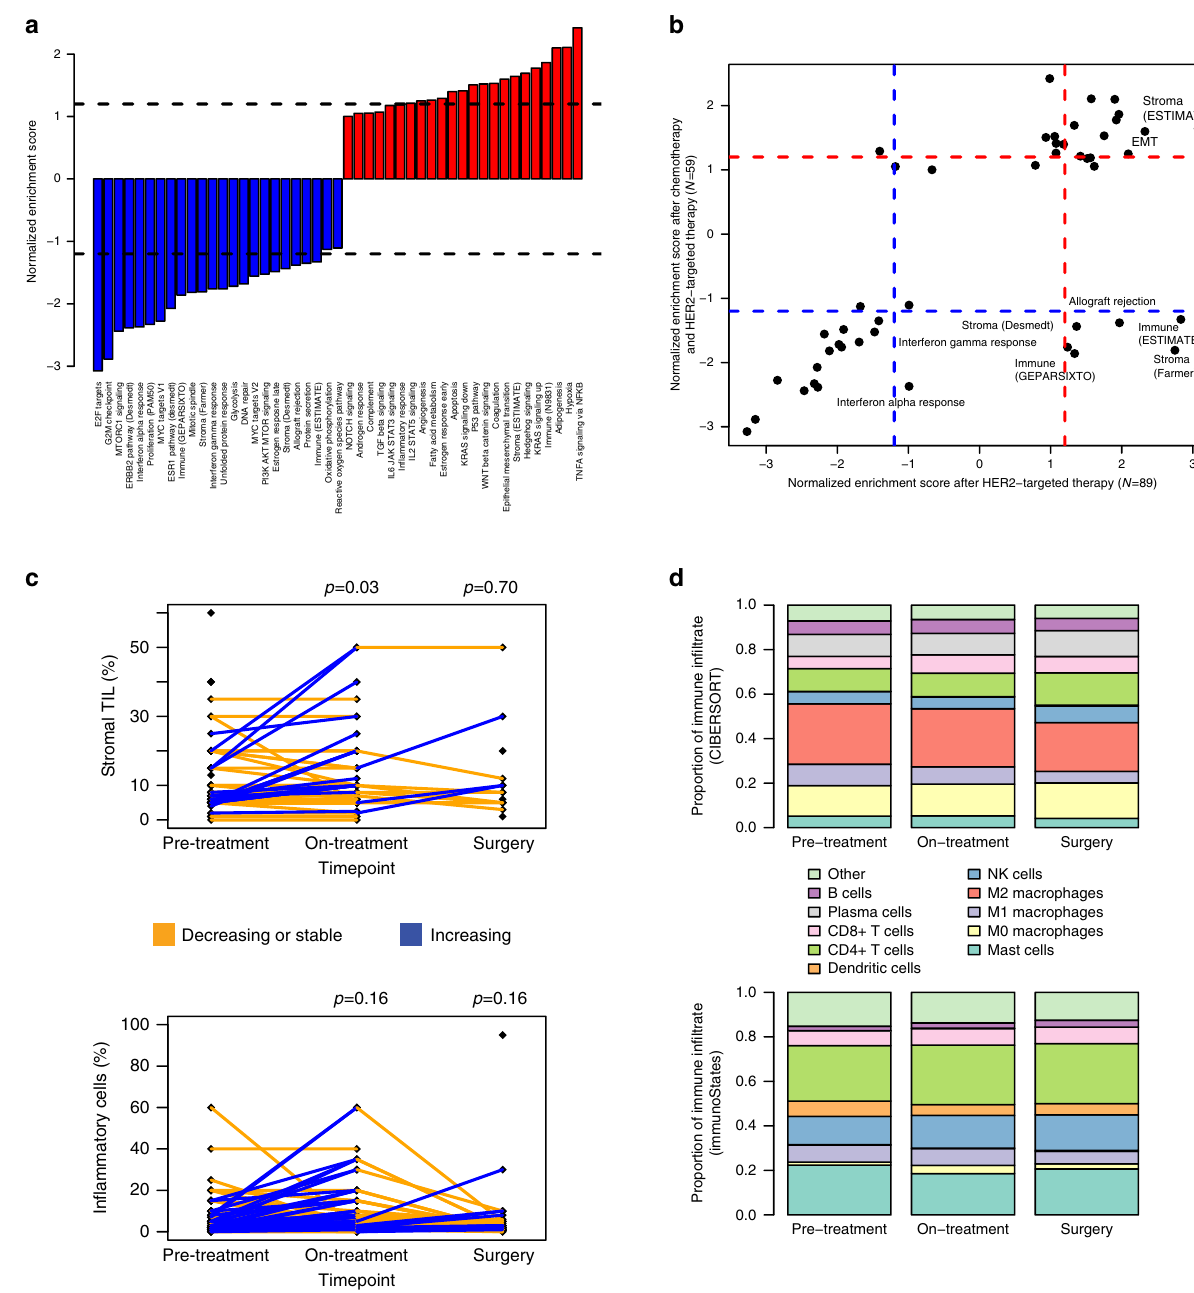
Fig. 4 Microenvironment changes across HER2-targeted therapy and chemotherapy. a Normalized enrichment scores from gene set enrichment analysis (GSEA) representing the degree of change of each gene set at the time of surgery compared to pre-treatment. Dotted lines separate those with FDR < 0.1. b Normalized enrichment scores at surgery compared to pre-treatment ( y -axis) vs after 14 – 21 days of HER2-targeted therapy compared to pre-treatment ( x -axis). Dotted lines separate those with FDR < 0.1. Immune and some stromal sets increase after 14 – 21 days of HER2-targeted therapy but are reduced at the time of surgery. c Change in stromal TILs and in fl ammatory cell percentage across treatment. P -values are from two-sided paired t -tests, comparing on- treatment to pre-treatment ( N = 55 for stromal TIL and N = 94 for in fl ammatory cells) and surgery to pre-treatment ( N = 14 for stromal TIL and N = 78 for in fl ammatory cells). d Proportion of immune in fi ltrate represented by each immune cell subtype, according to CIBERSORT (top) and immunoStates (bottom). Pre-treatment ( N = 89) is matched to on-treatment ( N = 89); surgery ( N = 59) is a subset. TIL: tumor-in fi ltrating